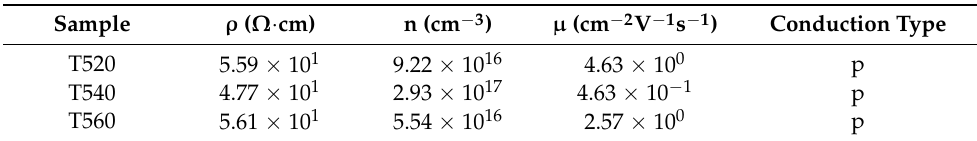
Table 2. Electrical properties of the Na-doped Cu 2 ZnSn(S,Se) 4 films selenized at different tempera- tures ranging from 520 to 560 °C.